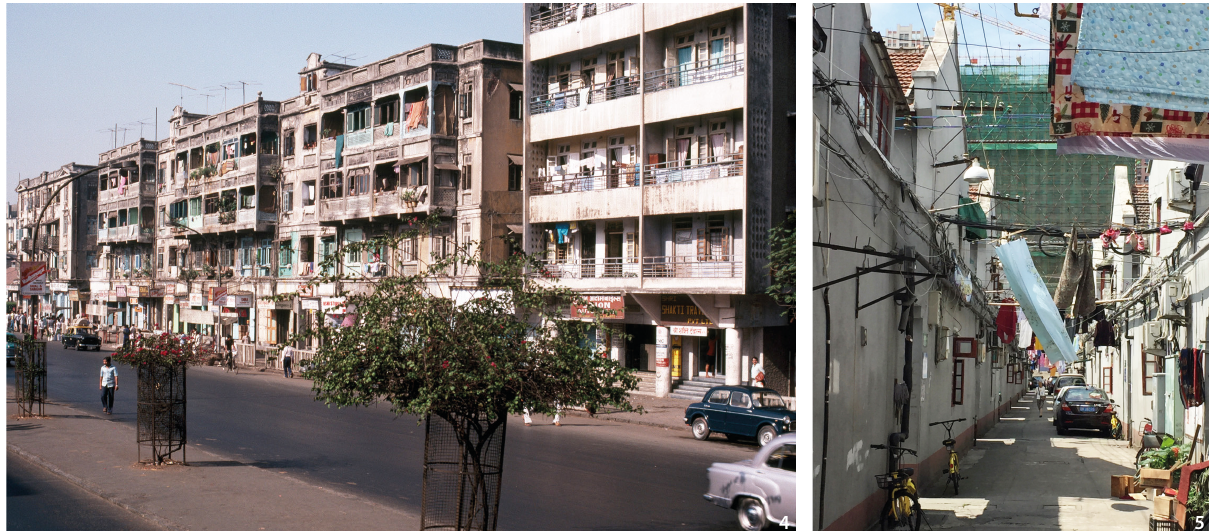
Figure 4 Chawls in Parel district, Mumbai, 1983 (Source: Aga Khan Visual Archive, Massachusetts Institute of Technology Libraries, photo by Shubhankar Sanyal). Figure 5 Shanghai lane-alley ( lilong ) style workers’ housing, adjacent site of former Number 19 Cotton Mill, Yangpu District, 2017 (Source: the